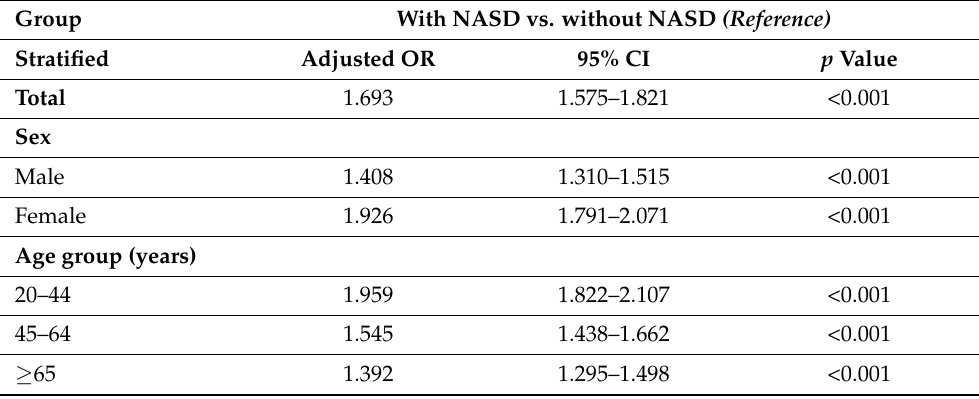
Table 3. Factors of obesity stratified by variables using logistic